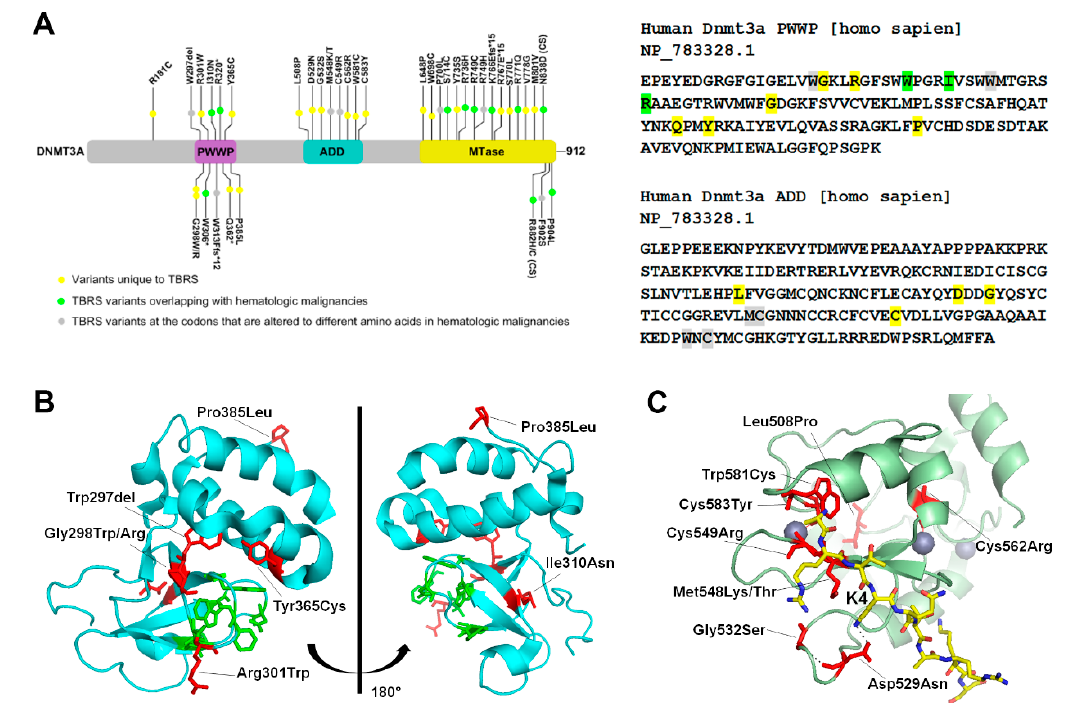
Figure 2. TBRS (Tatton-Brown-Rahman syndrome) mutations in the PWWP and ADD domain of DNMT3A ( A ) Left Schematic representation of the hDNMT3A gene, with mutations listed in different domains. Variants unique to TBRS are highlighted in yellow, TBRS variants overlapping with hematologic malignancies are highlighted in green, and TBRS variants at the codon that are altered to different amino acids in hematologic malignancies are highlighted in grey. In the schematic, (*) is used to indicate a stop codon replacement, Ffs indicates a frame-shift mutation, and CS indicates the catalytic site. Right Nucleotide sequence of the PWWP (Pro-Trp-Trp-Pro) and ADD (ATRX-DNMT3-DNMT3L) domain, with the mutations highlighted in the color corresponding to the schematic. ( B ) Two orientations of the DNMT3A PWWP domain (PDB: 3LLR). The positions of TBRS mutations are shown as stick structures in red, whereas residues part of the aromatic cage that bind to H3K36me2/3 shown as stick structures in green. ( C ) Crystal Structure of the DNMT3A ADD domain (PDB: 4U7T), in green bound to an unmodified H3 peptide shown as a stick structure in yellow. Grey spheres represent bound zinc. The positions of TBRS mutations are shown as a stick structure in red.